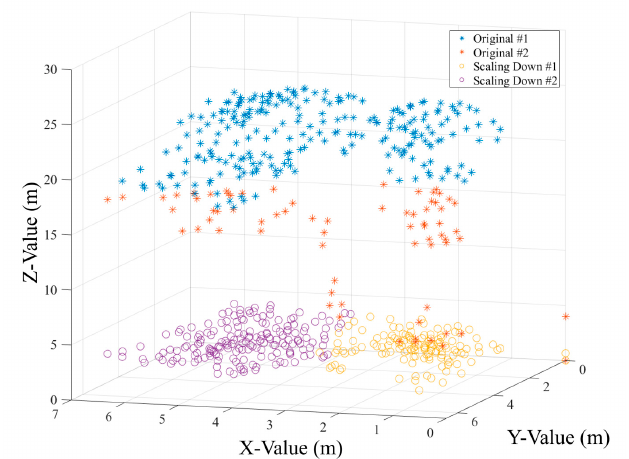
Figure 8. The result of the k-means clustering based on the tree number defined in Section 3.3.3. The asterisks represent the original tree points belonging to the segment; the di ff erent colored asterisks represent the k-means segmentation results. The circles represent the scaled-down canopy points colored using the k-means segmentation result.